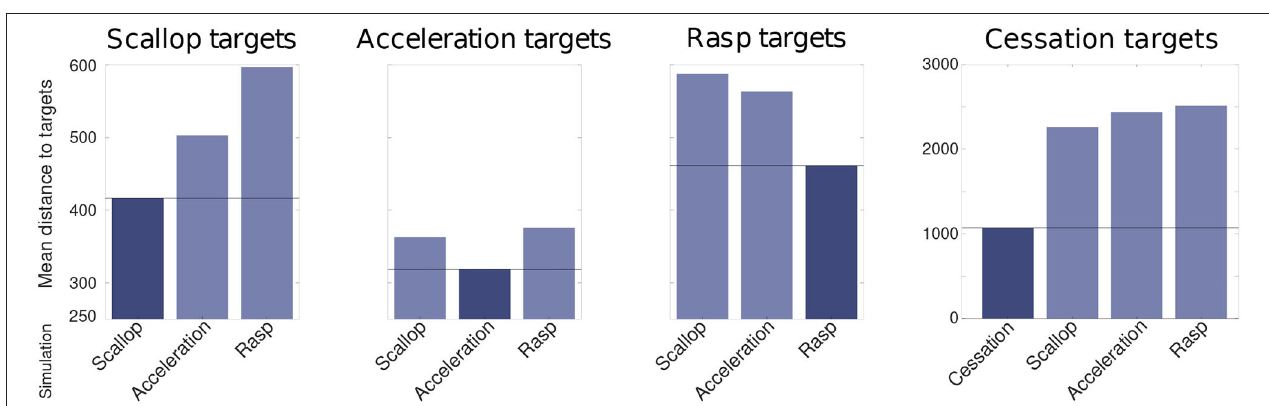
FIGURE 7 | Mean euclidean distance (calculated after the evaluation function steps depicted in Figure 3 ) between each target SPI pattern and the simulated SPIs during the R-GA robustness analysis. Each chart shows the distance calculated to a different target SPI: scallop, acceleration, rasp, and cessation; and the darkest bar in each chart highlights the simulations corresponding to that target. This bar was expected to be minimum in each case as it represents the mean distance between the set of simulations of a specific SPI and its corresponding target. This held true for all cases. Differences from cessation simulations are not depicted to improve the clarity of the comparison because they are in a larger order of